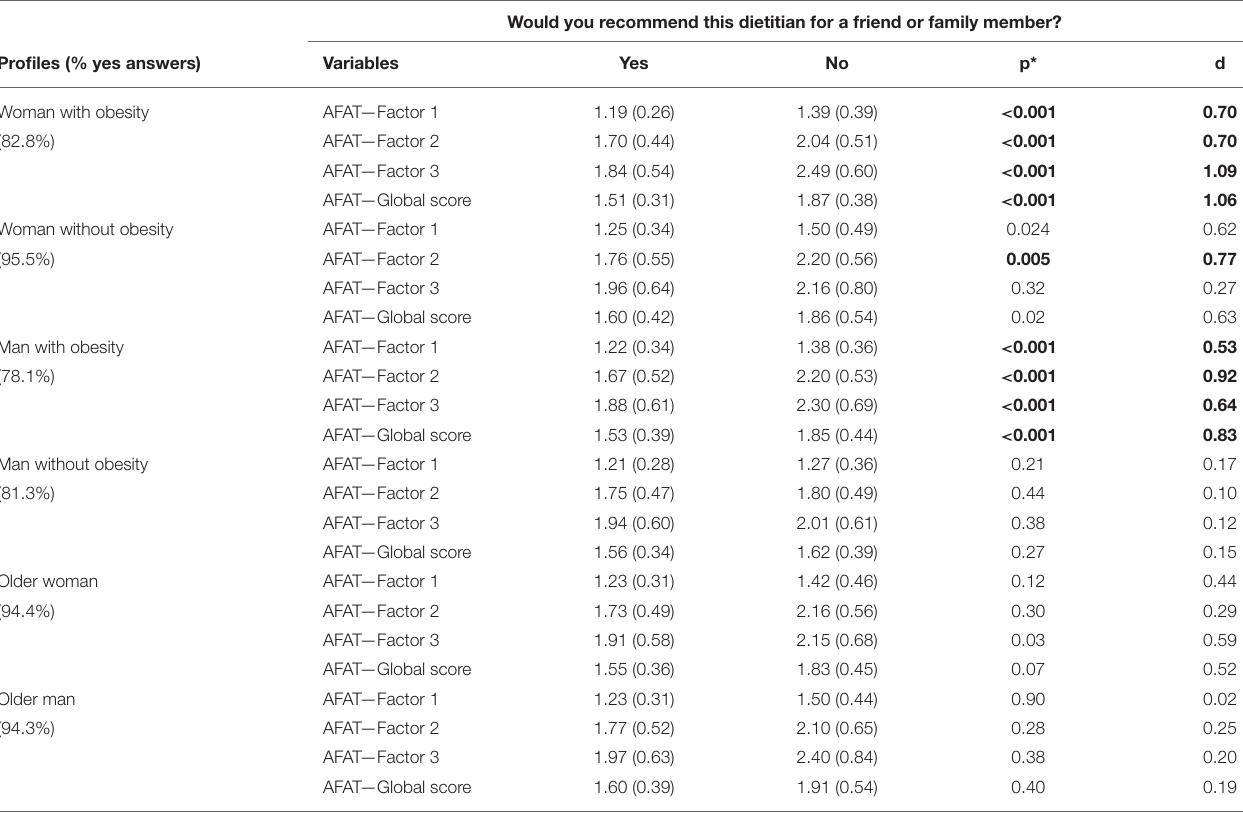
TABLE 4 | Dietitians and nutrition students’ willingness to recommend each dietitian and Antifat Attitudes Test (AFAT) scale and subscales scores. Would you recommend this dietitian for a friend or family